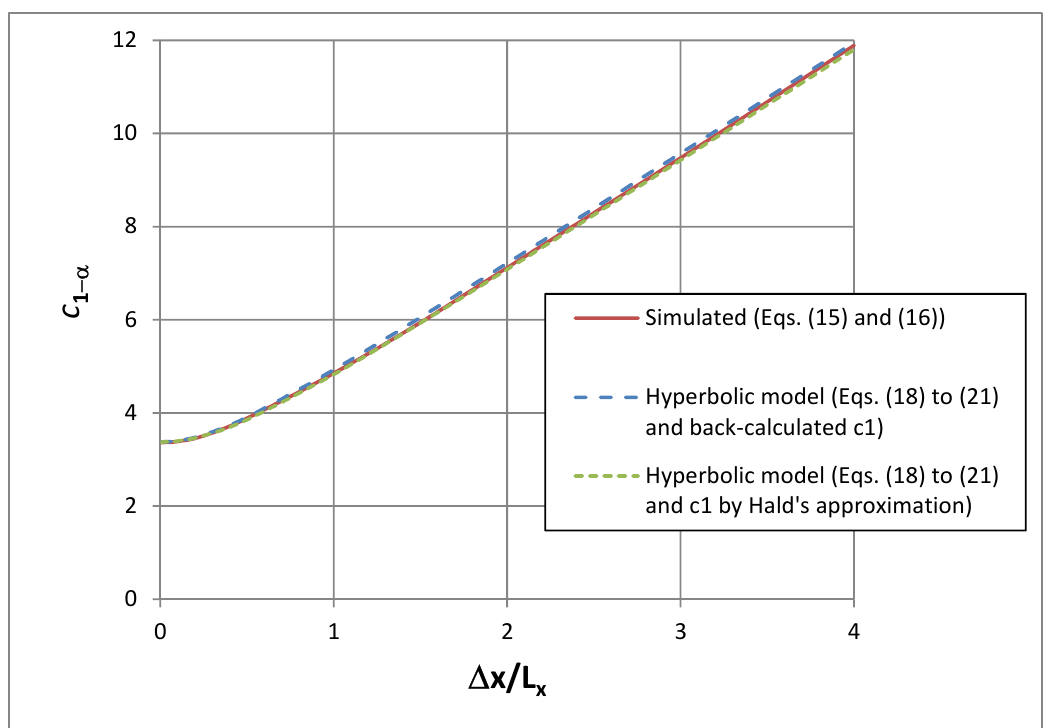
Figure 3. Comparison between the true (simulated) c 1 − α values and the c 1 − α values obtained by the hyperbolic model for n = 8, γ = 0.95 and 1 − α = 0.95.